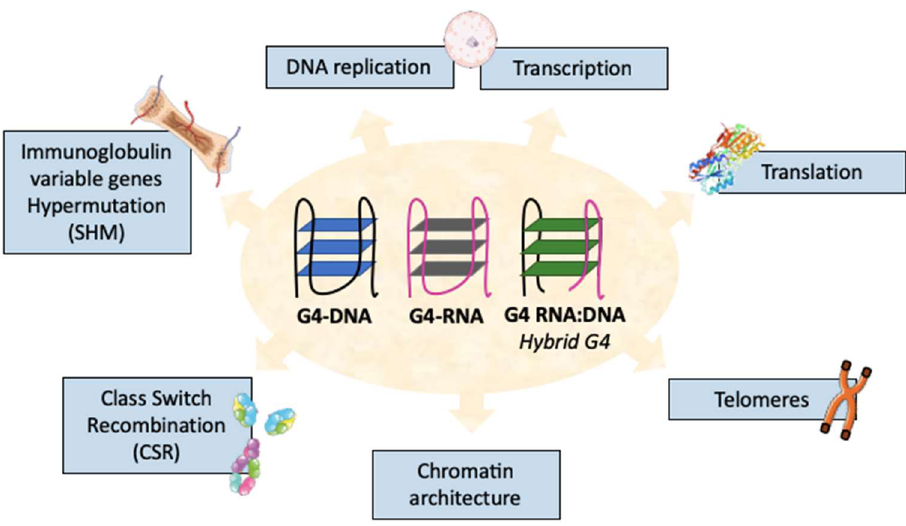
Figure 1. Multiple biological functions of G-quadruplexes (G4s). G4s have different conformations such as G4-DNA, G4-RNA, or G4-RNA:DNA called hybrid G4s. These structures are found at many locations in the genome and are implicated in multiple biological processes.